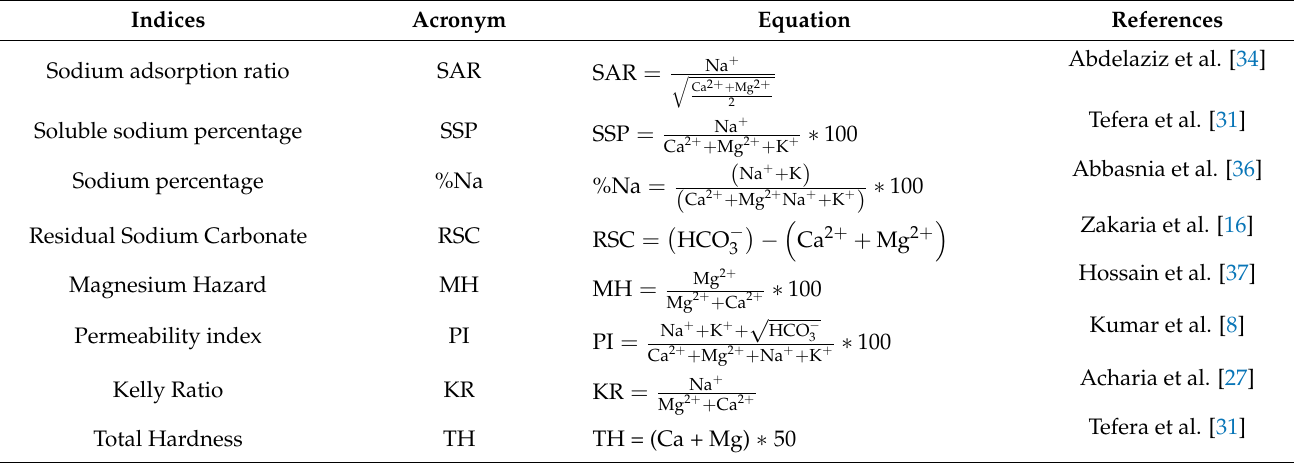
Table 1. Groundwater indices based on hydrochemical